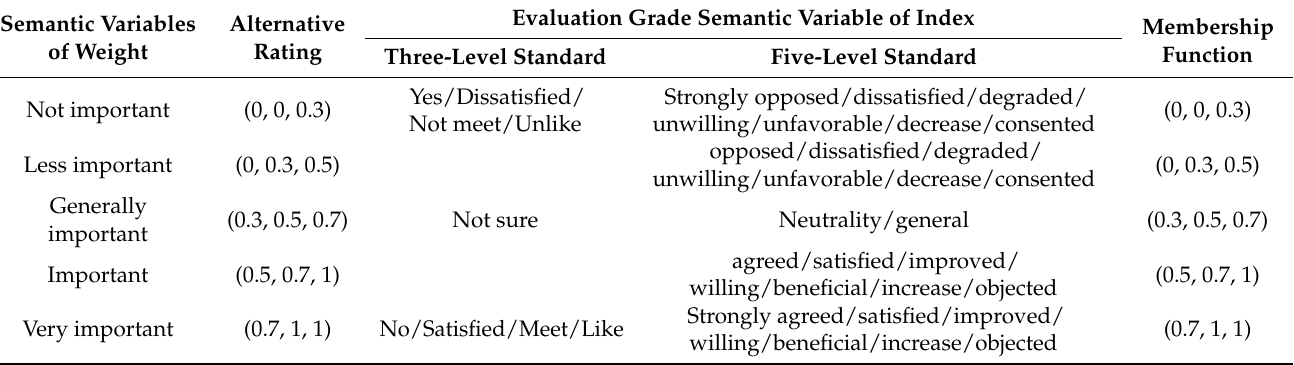
Table 3. Semantic variables of index and Triangular Fuzzy